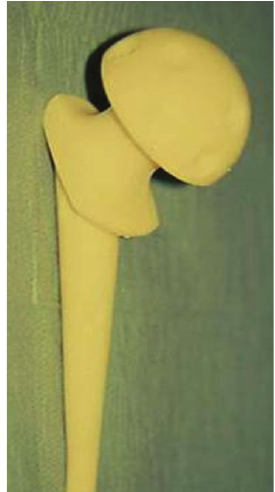
Figure 2: Image of the preformed gentamicin-loaded cement spacer after surgical addition of vancomycin using the “surface drill hole” technique.